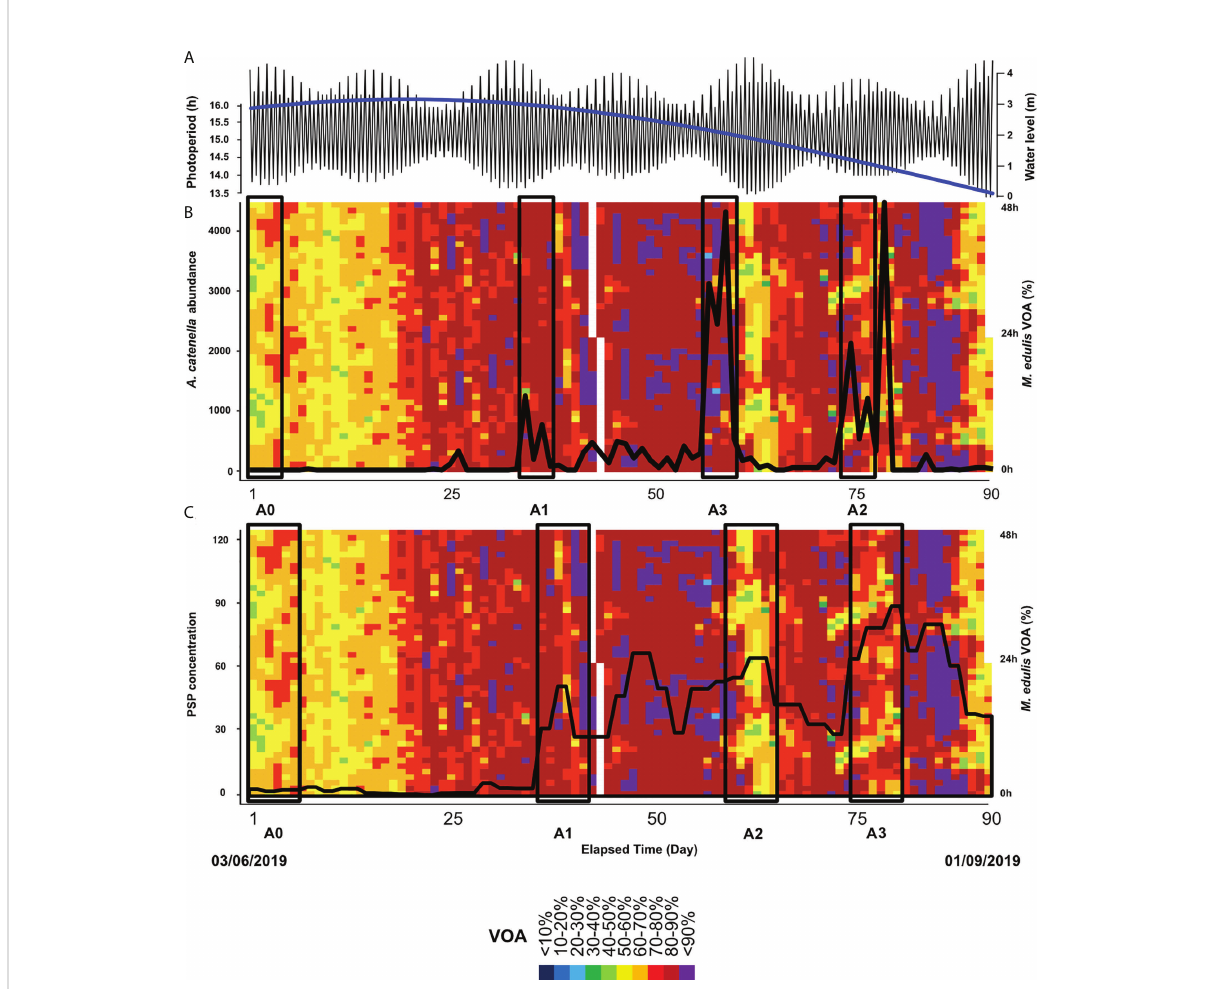
FIGURE 2 Physical and biological observations over the course of the 90-day natural seawater experiment. In panel a, the blue and black lines represent photoperiod and water level, respectively. The actograms depict the mean hourly VOA (%) of the group (n = 27 mussels) in relation to (A) . catenella abundance (panel B , black line) and PST concentration in the mussel tissue (panel C , black line). The black rectangles represent the times windows studies, with a duration of 4 days for panel b and 6 days for panel (C)